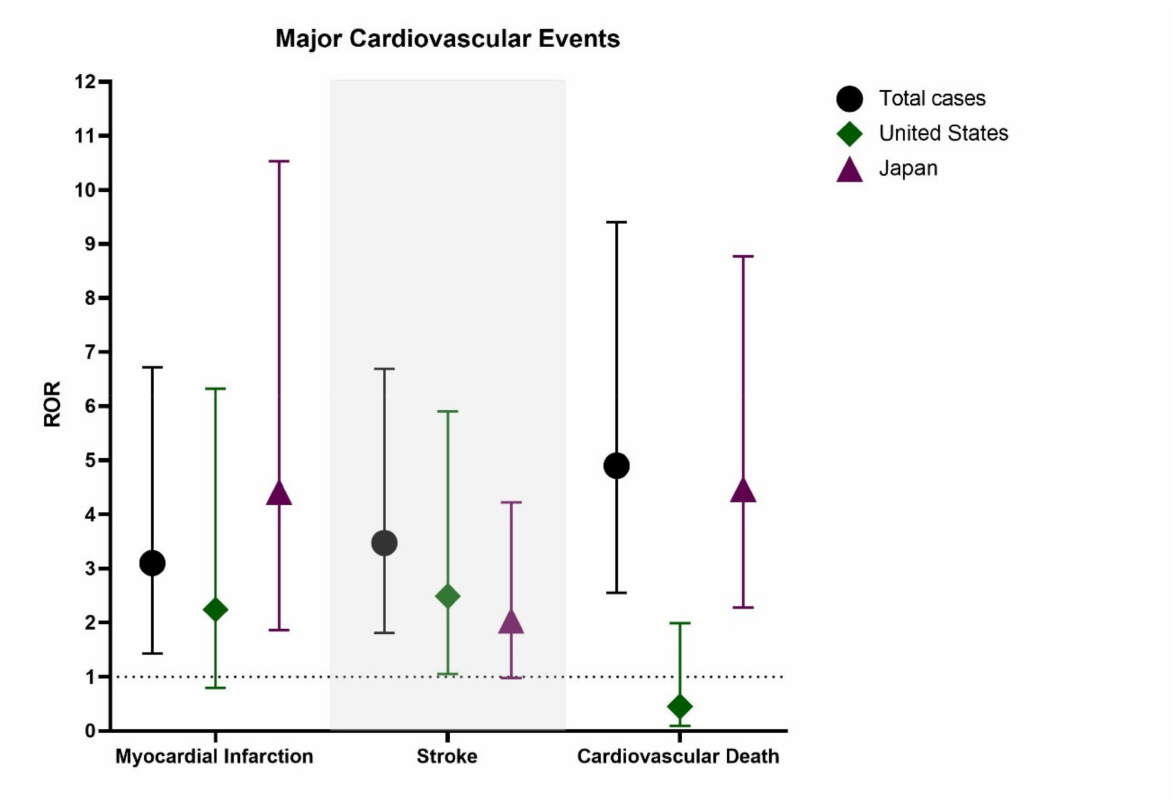
Figure 2. Disproportionality analysis of suspected major cardiovascular events (MACE) for romosozumab compared with all other medications in the US Food and Drug Administration Adverse Event Reporting System (FAERS), stratified by the overall ( N = 1995) and reporting region (United States, N = 787) and Japan ( N =